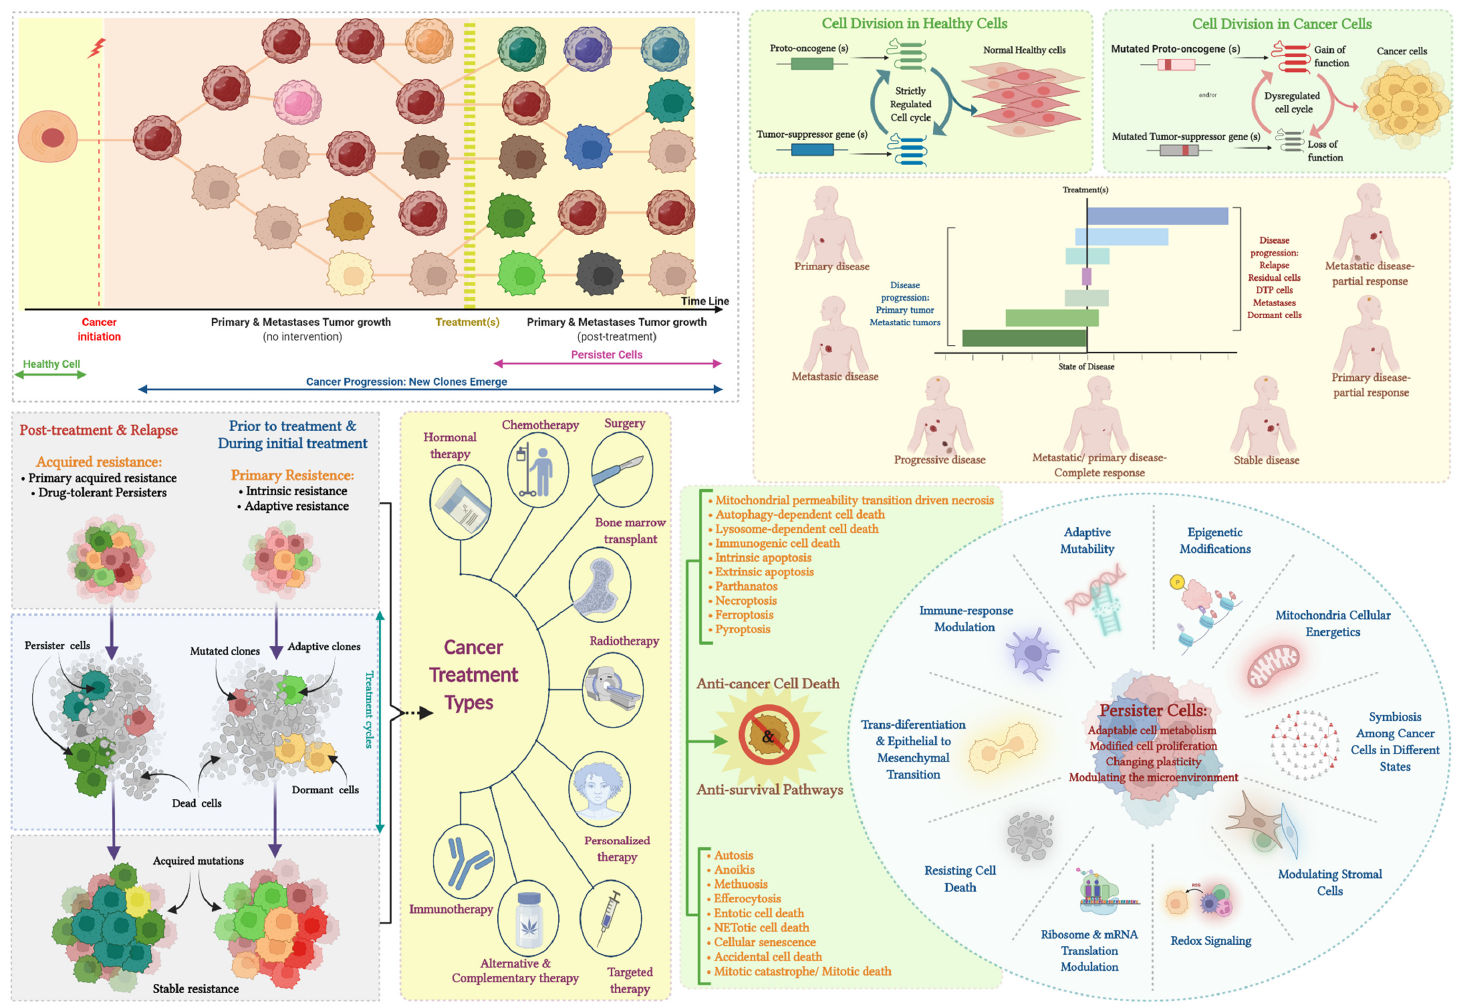
Figure 6. Resistance to cancer therapies, clonal selection, and cancer cell survival: Cancer treatment can involve either a single therapy or combination of surgery, targeted therapies, radiotherapy, broad spectrum chemotherapeutics, immune-therapeutics, hormonal therapy, personalized therapy, bone marrow transplants, and complementary and alternative medicine. Malignant cells display resistance to treatments through a myriad of genetic and non-genetic mechanisms. The